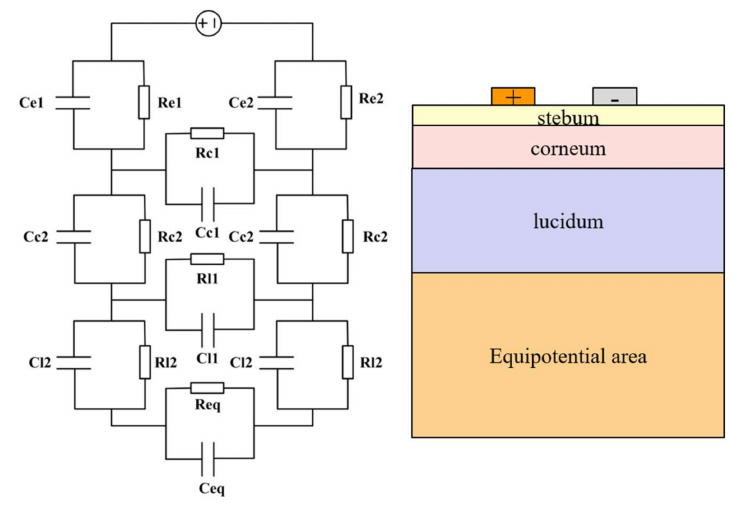
Figure 4. Equivalent circuit of human skin impedance measurement, which considers the layered nature of the skin, so the layered impedance was built vertically as well as the interlayer skin impedance in the horizontal direction [40].